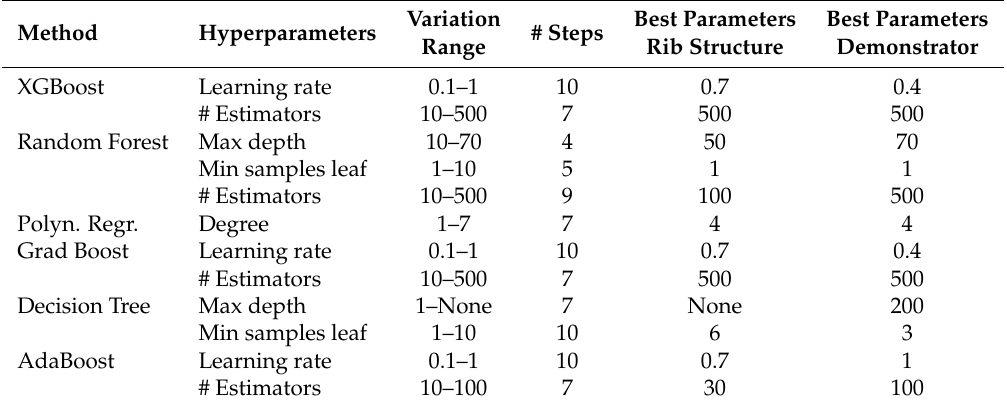
Table 3. Overview of hyperparameter optimization of deployed data-driven